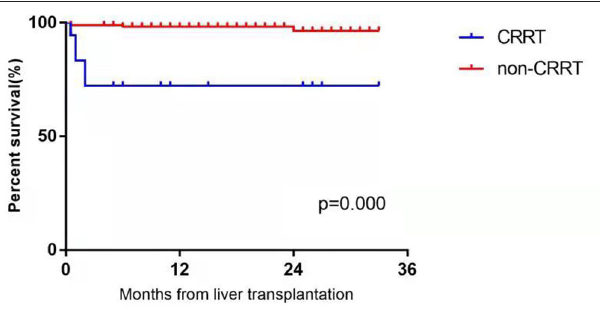
FIGURE 1 | The postoperative survival curves in the CRRT group and non-CRRT group of infants and younger children with acute kidney injury after liver